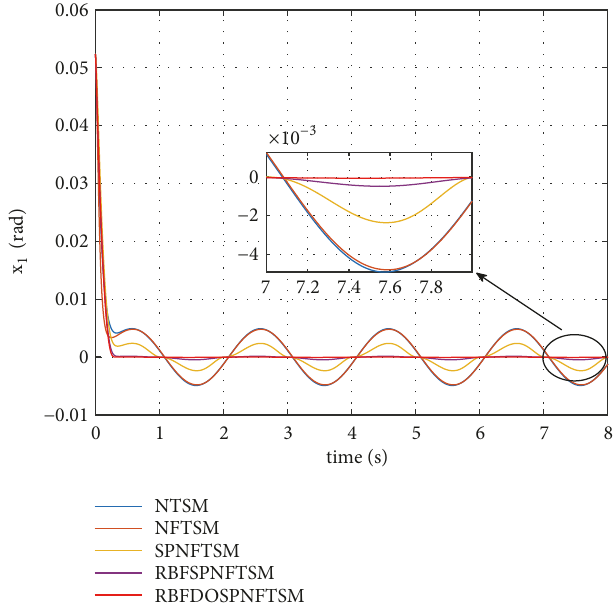
Figure 3: Swing angle response curve.